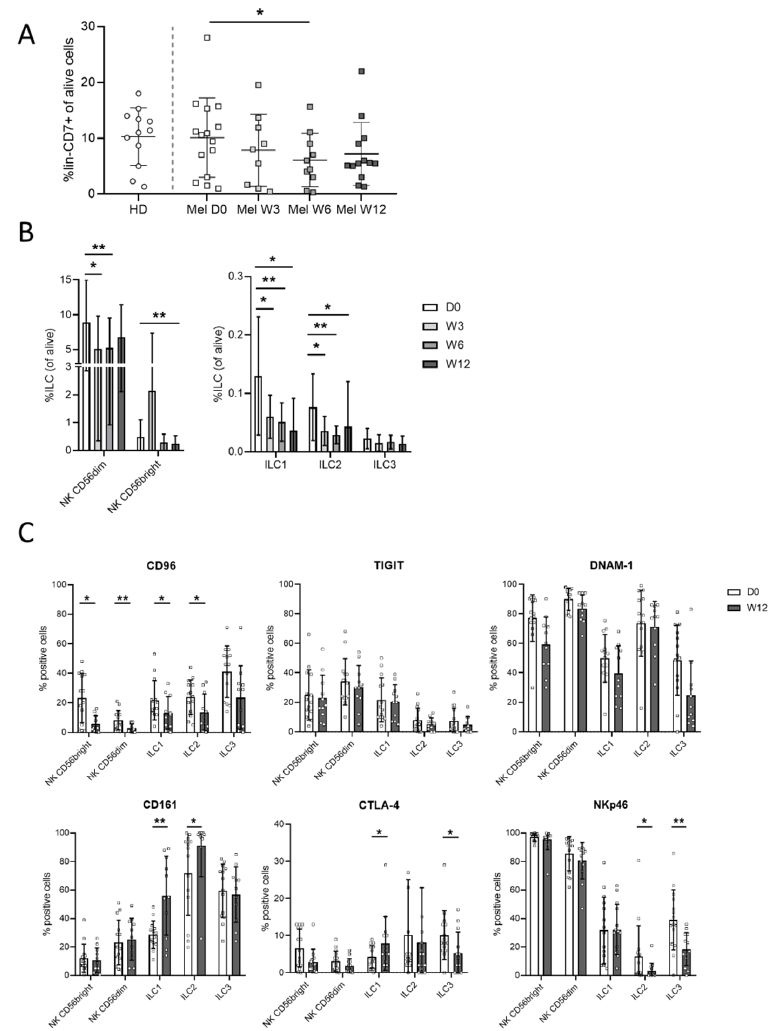
Figure 3. Phenotypic assessment of the immune checkpoint in ILCs from patients treated with ipilimumab. Percentages of lin - CD7 + ILCs in live PBMCs from donors and patients following ipilimumab treatment at day 0, weeks 3, 6 and 12 (D0, W3, W6, W12) ( A ). Percentages of the different ILC populations in lin - CD7 + cells in patients following treatment ( B ). Ex- pression of receptors in ILC populations in patients at D0 and at W12 of treatment ( C ). A Wilcoxon matched-pair signed rank test was used to compare percentages between D0 and other times of treatment (* p < 0.05, ** p < 0.01).